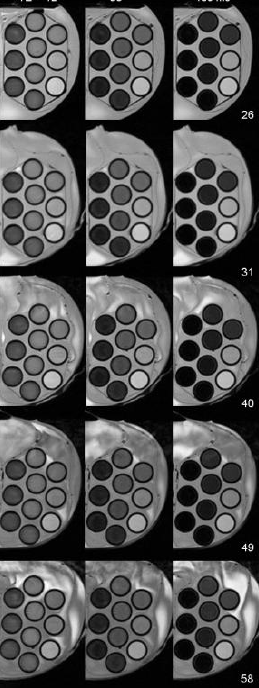
Figure 6. Spin-echo images at 1.5T at different echo times and temperatures. The images show larger signal decay due to higher nanoparticles concentrations, longer echoes, and lower temperatures. In order to understand the signal weighting by T1 and T2 relaxation times, quantitative measurement of many nanoparticle-specific parameters are needed such as particle size and the degree of agglomeration. Any possible variation of these parameters (and the magnetic moment) with temperature must also be taken into account.